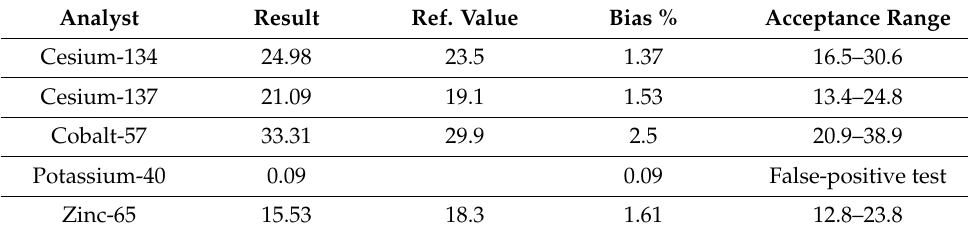
Table 4. The most recent participation in the MAPEP